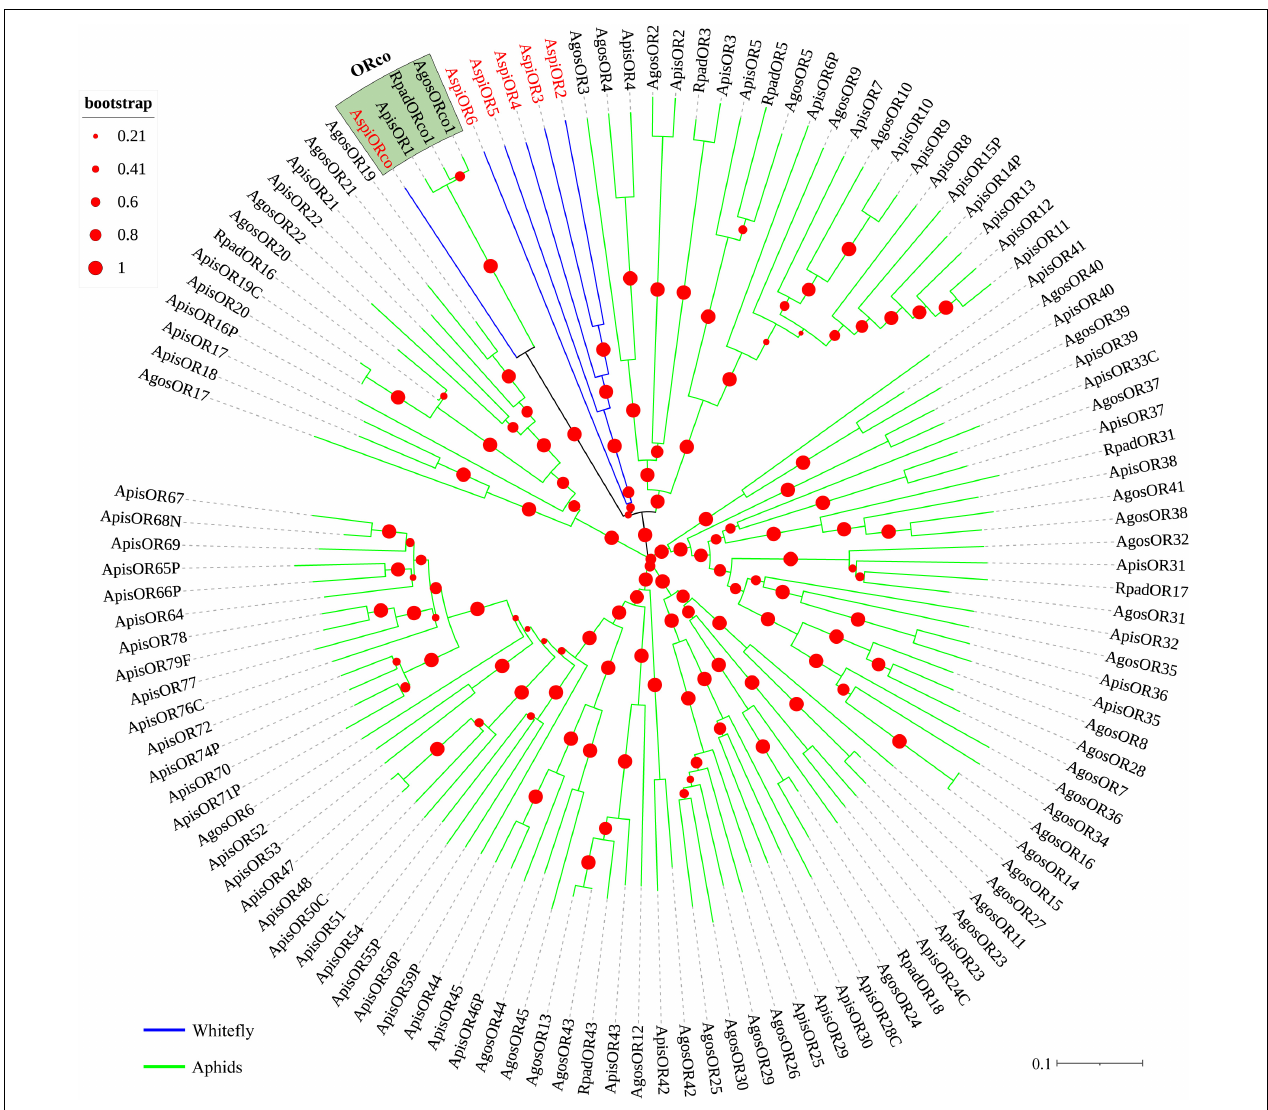
FIGURE 5 | Phylogenetic analysis of putative odorant receptors (ORs) of A. spiniferus . The phylogenetic tree was built using OR sequences from whitefly specie (Aspi, A. spiniferus ) and aphid species (Apis, A. pisum ; Rpad, R. padi ; Agos, A. gossypii